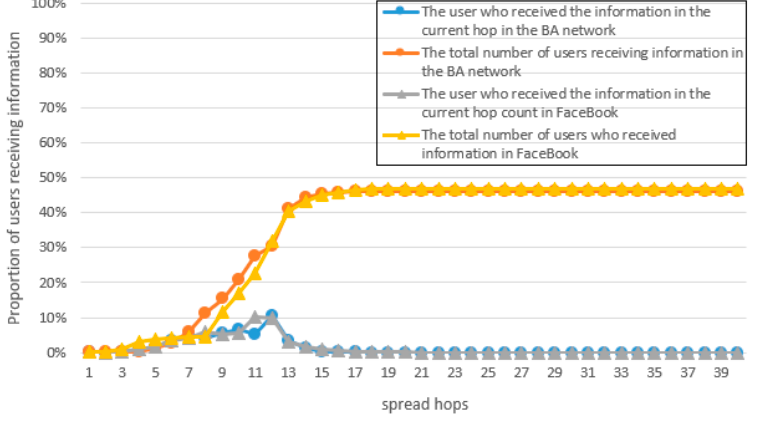
Figure 10. The dissemination process of the privacy information of high popularity users in the BA and the Facebook networks.